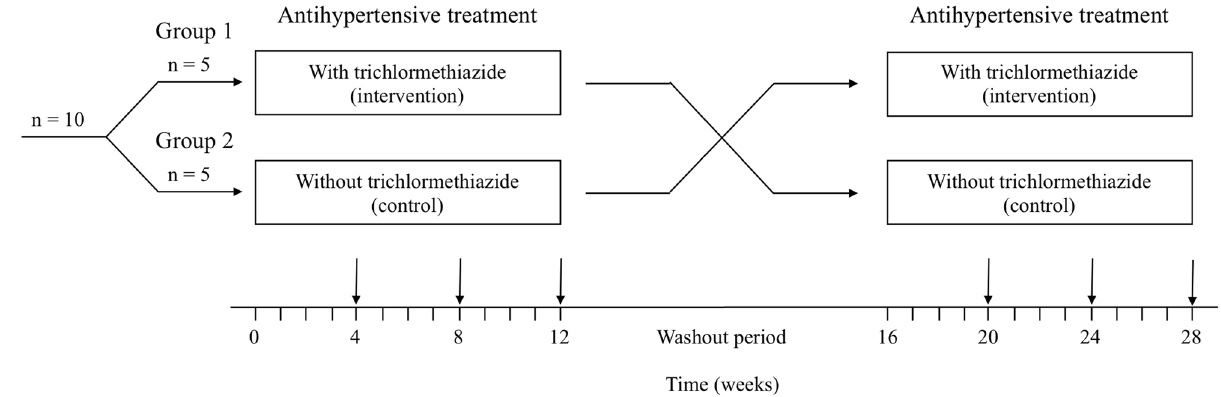
Figure 3. Crossover flow chart of the trial